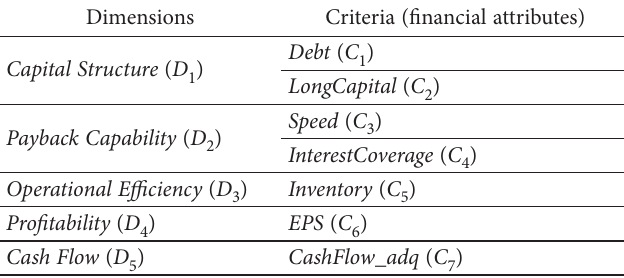
Table 6. Financial attributes that implied high